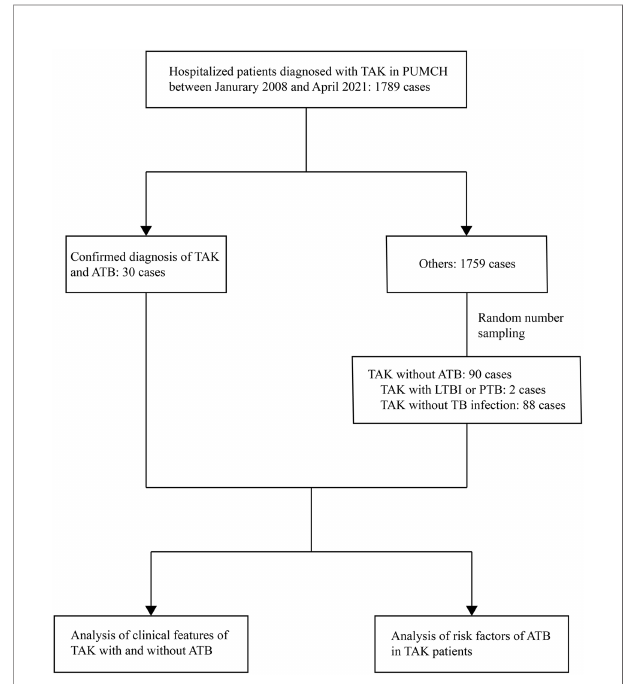
FIGURE 1 | Flow chart of the study. TAK, Takayasu arteritis; PUMCH, Peking Union Medical College Hospital; ATB, active tuberculosis; LTBI, latent tuberculosis infection; PTB, previous